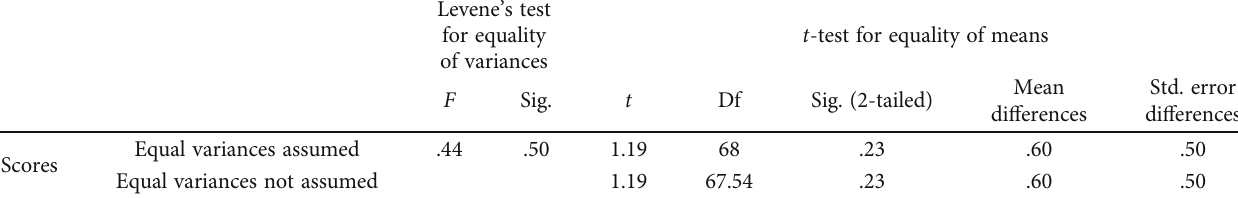
Table 2: Inferential statistics of both groups on the listening pretest.